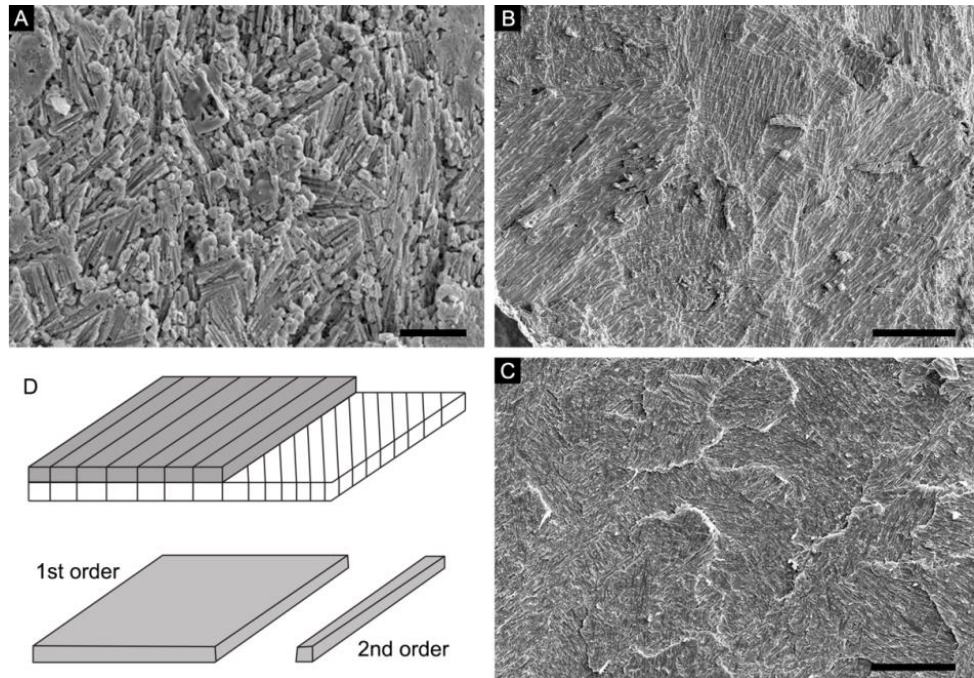
Figure 1. Schematic diagram of the LF nacre and similar fibrous microstructure in extant and fossil groups ( A ) Specimen NRM Mo196854, prismatic microstructure showing a fibrous and crisscrossed appearance on surface of internal mold of a Cambrian helcionelloid Postacanthella specimen. ( B ) Specimen OUCCMG An00001, similar fibrous and crisscrossed morphology of the ordered-chevron microstructure seen on the internal surface of modern serpulid tube. ( C ) Specimen OUCCMG Mo00001, overview morphology of the LF nacre of extant cuttlebones. ( D ) Schematic diagram of the LF nacre showing hierarchical orderings. Scale bars: 20 μm in ( A – C ).